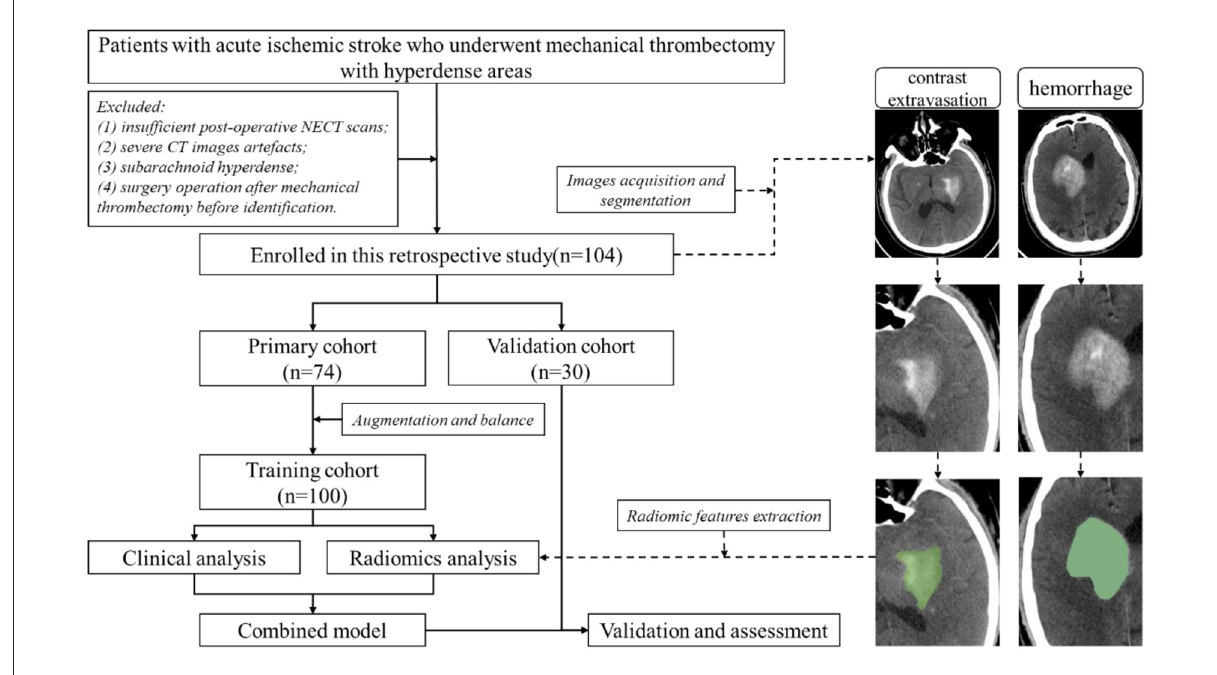
FIGURE1 The flow chart of patients’ enrollment and image analysis